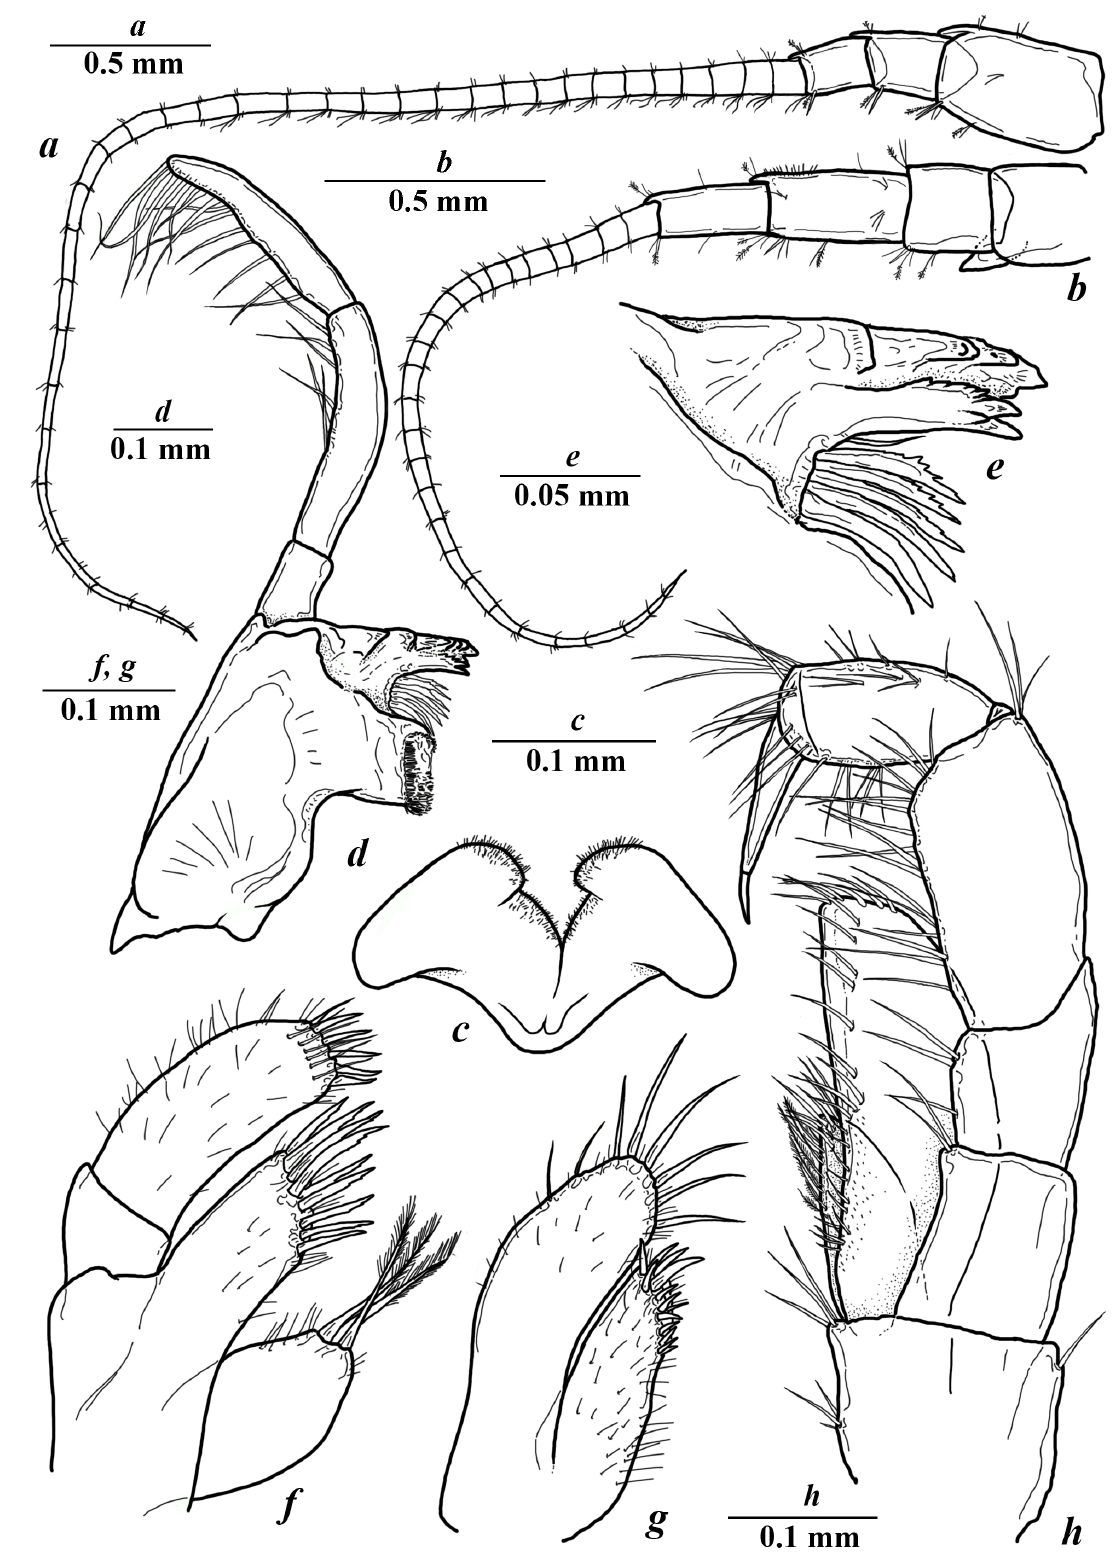
Fig. 2. Pleusymtes actiniae sp. nov., paratype, ♀ (ZMMU Mb-1224). a . Antenna I. b . Antenna II. c . Labium (lower lip). d . Left mandible. e . Left lacinia mobilis. f . Maxilla I. g . Maxilla II. h .